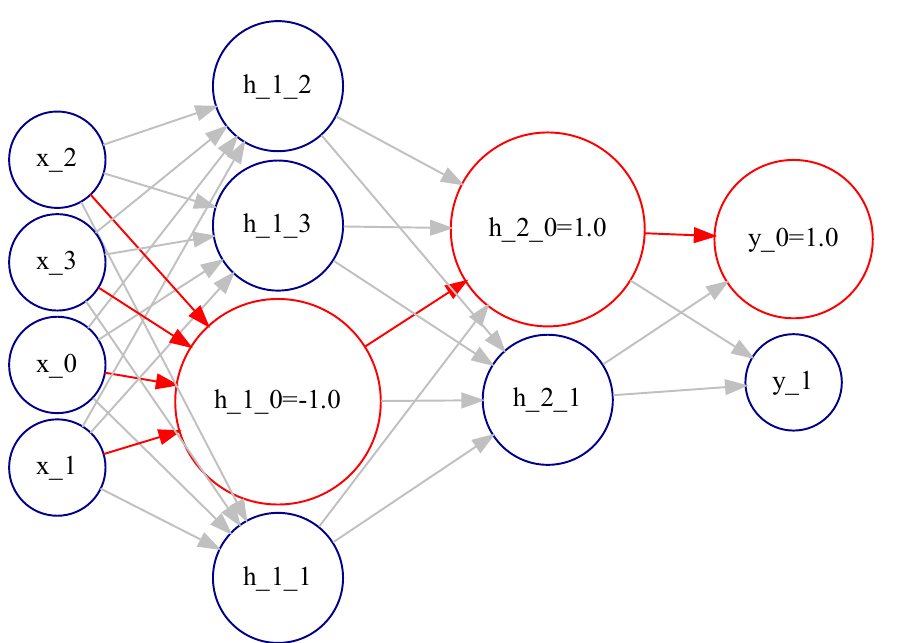
Figure 11. Banknote dataset activation pattern (automatically generated) for class 0 is highlighted in red over the DL predictor architecture. In addition, the most frequent activation values are shown for neurons in the activation pattern.